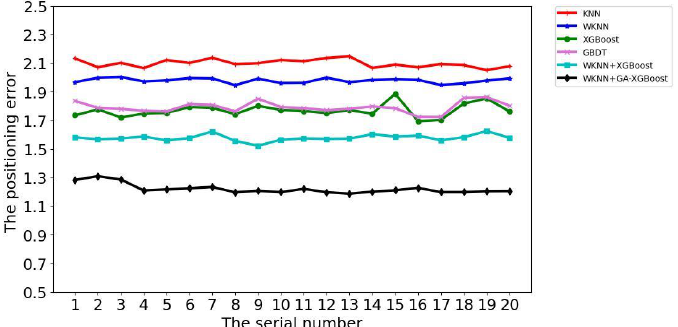
Figure 8. Comparison of positioning error .